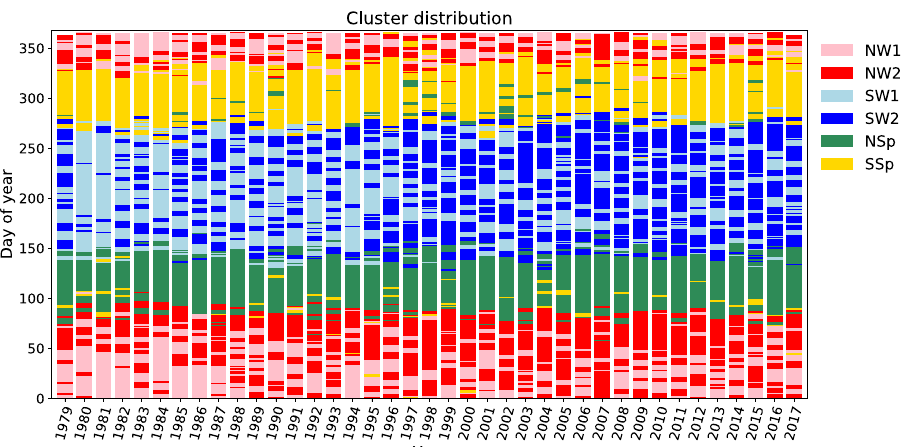
Fig. 2 Distribution of MMC cluster occurrence. Clusters are well separated by the seasons. Red and pink colors represent the boreal winter ( NW 1 and NW — the austral winter ( SW SW — transition seasons ( NSp for the boreal spring and SSp for 2 , respectively), light and dark blue 1 and 2 ), green and yellow